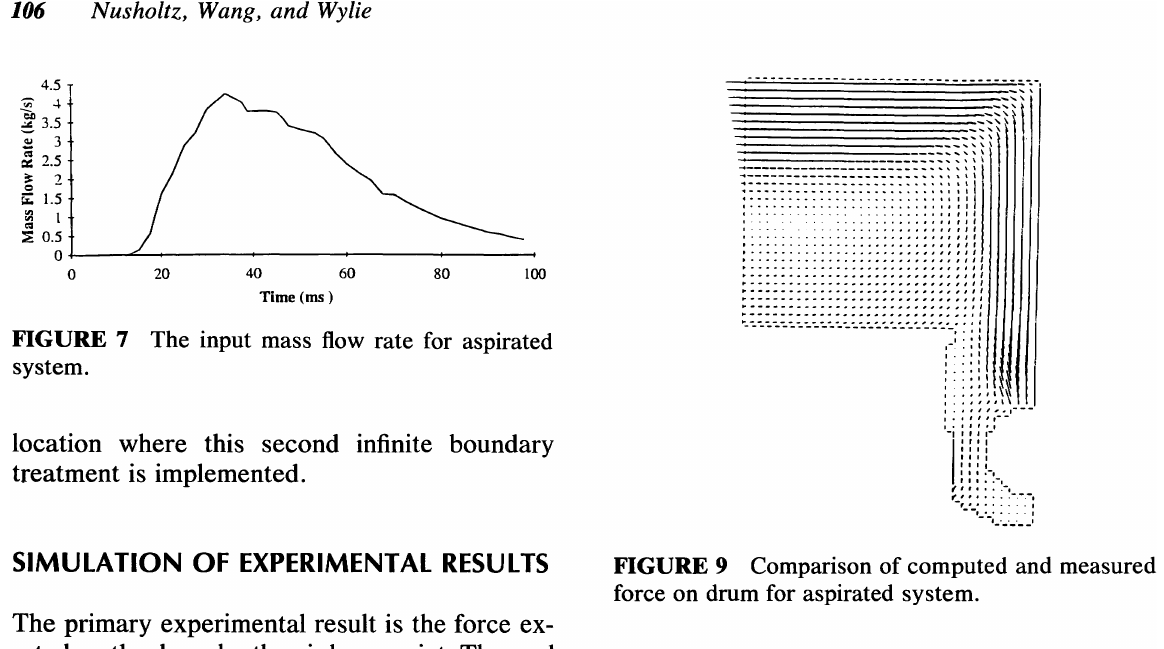
FIGURE 7 The input mass flow rate for aspirated system.